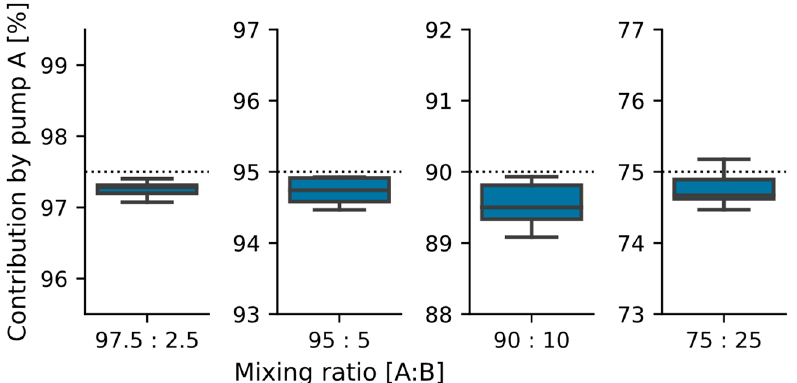
Figure 7. Dosing results for biased mixing ratios ( n = 4 ∗ 5). The target dosing ratio for pump A is shown in the plots as a dotted line. The mean and standard deviations are: 97.5: 97.3 ± 0.1%; 95: 94.7 ± 0.2%; 90: 89.5 ± 0.3%; and 75: 75.8 ± 0.3%. The overall deviation from the targeted mixing rate for all n = 20 data points is 0.3 ± 0.3%.